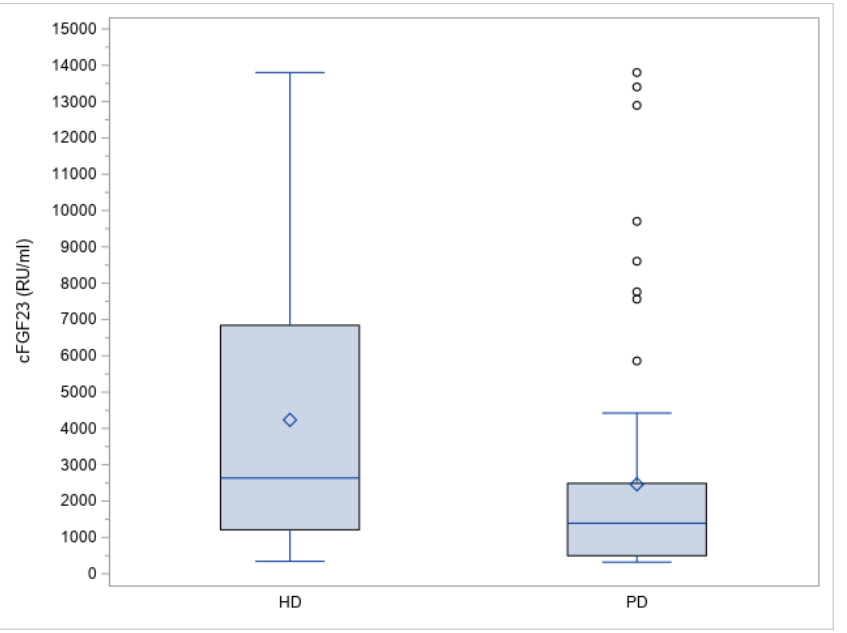
Figure 1. cFGF23 levels by type of renal replacement therapy (HD = hemodialysis, and PD = peritoneal dialysis). We found a statistically significant negative correlation (R = −0 .21; 95% CI: −0 .37 – 0.03) between cFGF23 and the UO volume ( p = 0.0250) (as represented in Figure 2), but the cor-